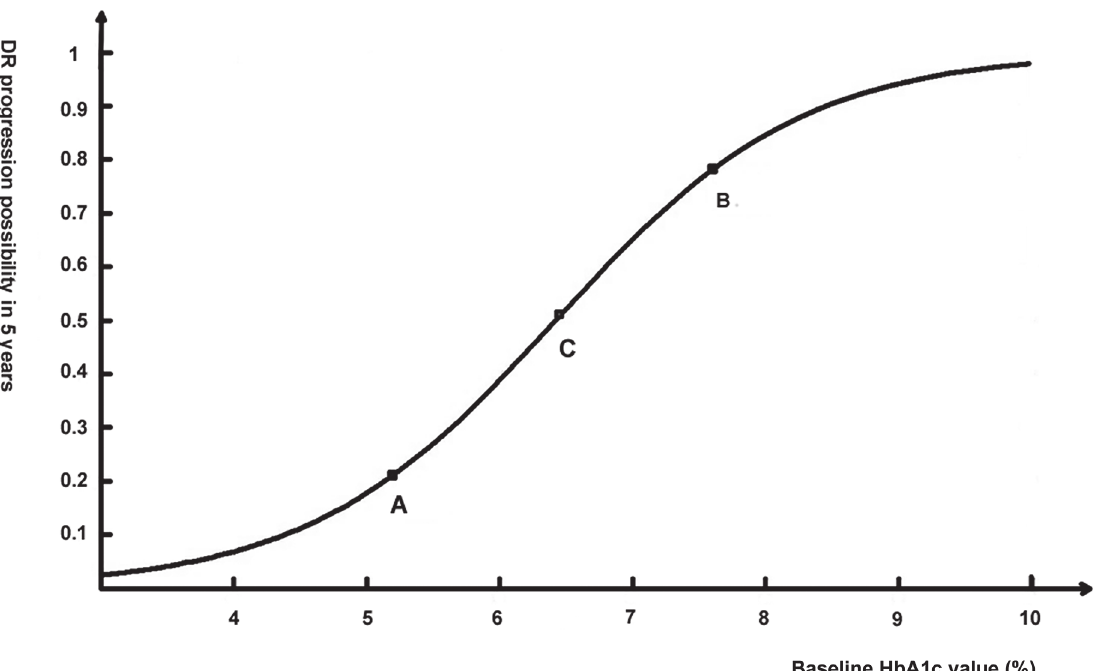
Fig 1. Logistic regression function curve: the association between initial HbA1c level and DR progression. Two maximum curvature points, A (5.2, 0.2) and B (7.6, 0.8), and one inflection point, C (6.4, 0.5), are labeled.